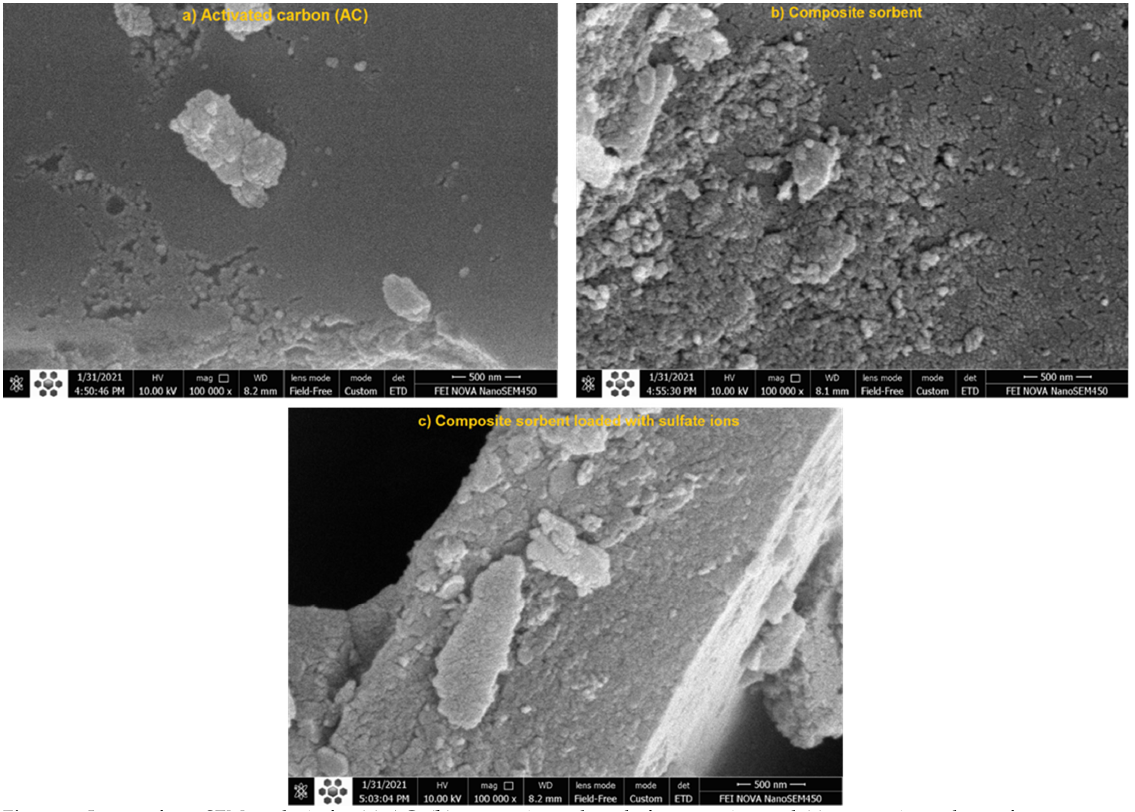
Figure 6. Images from SEM analysis for ( a ) AC, ( b ) composite sorbent before sorption and ( c ) composite sorbent after sorption of SO 42 − ions at 500 nm magnification scale.